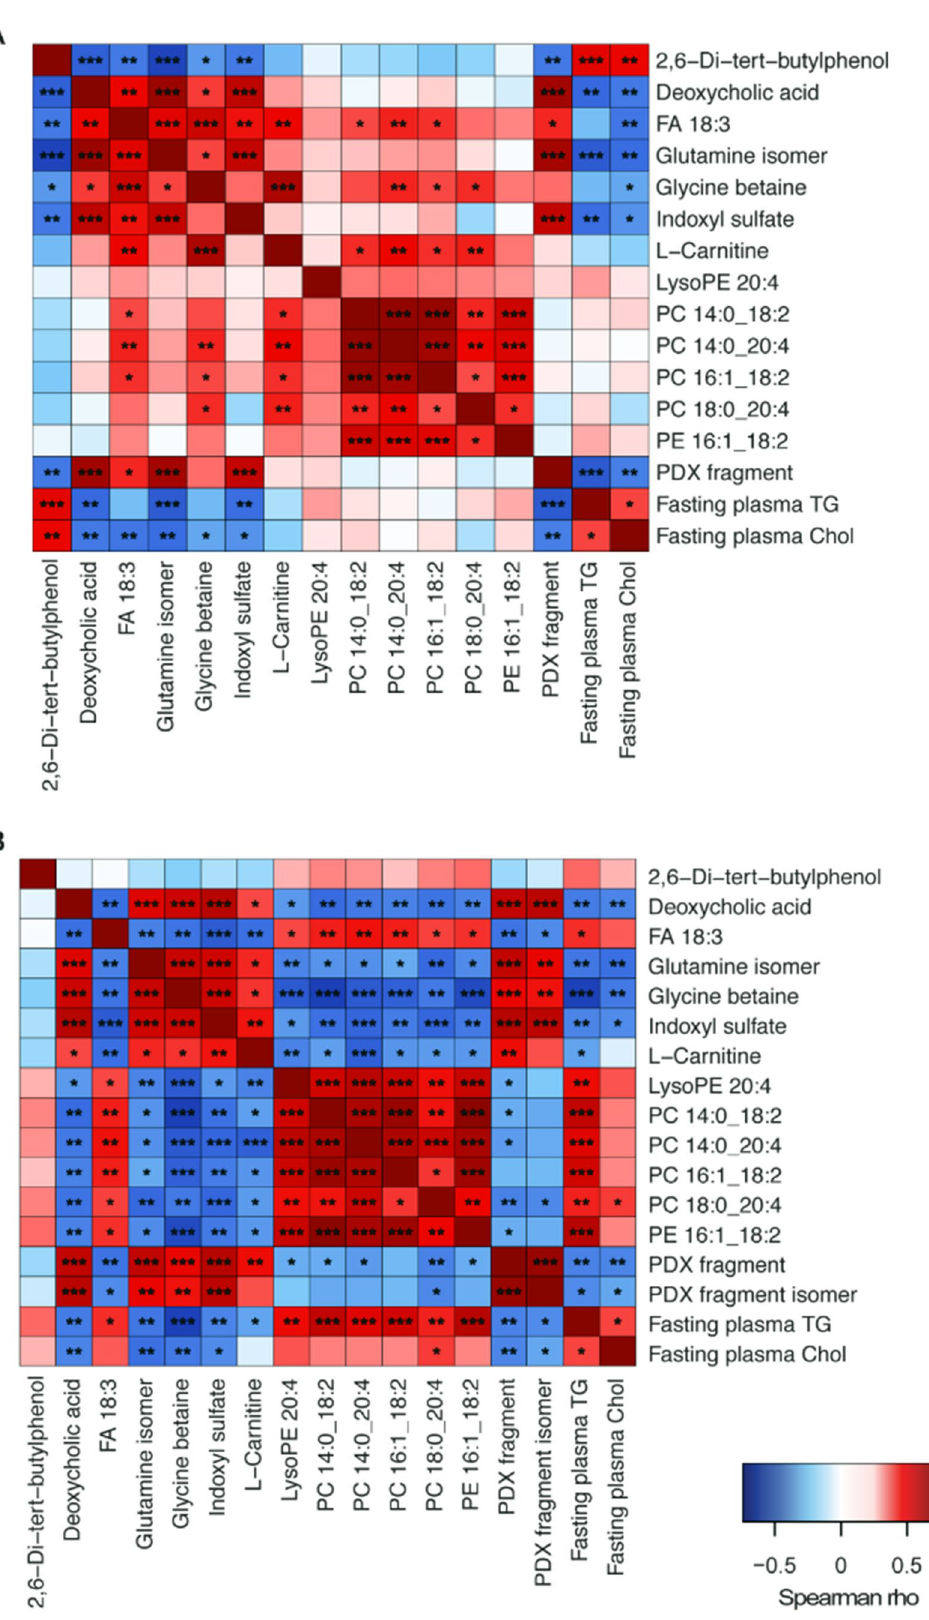
Figure 5. Heatmap showing correlations between fasting plasma TG and total cholesterol levels and metabolites in ( A ) adipose and ( B ) plasma, for both control Western diet (WD)-fed mice WD diet-fed mice administered polydextrose (PDX). *** p < 0.001, ** p < 0.01, * p <